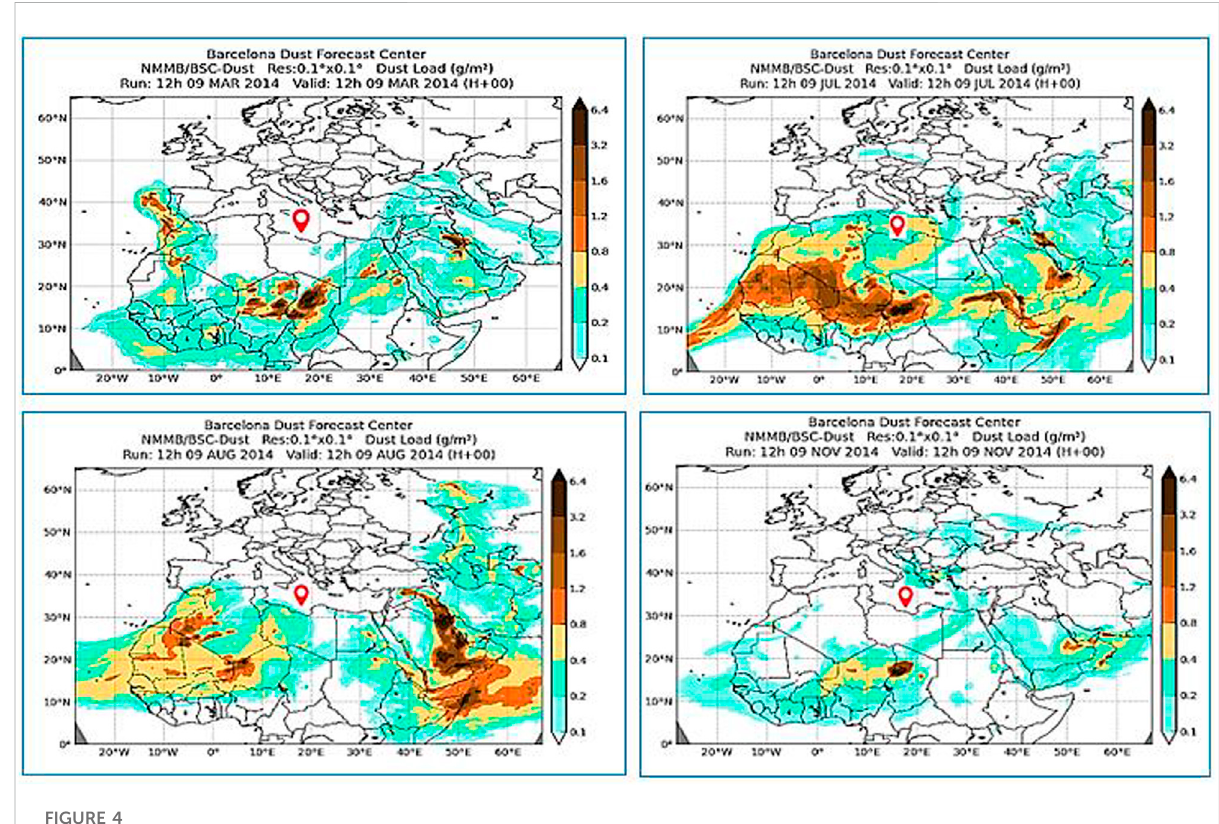
Dust loadings on selected months during sampling